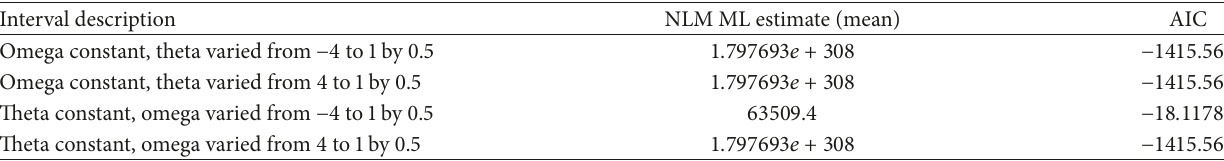
Table 10: Summary of results for lambda = 0.1, 𝑛 = 10 𝑖 , 𝑖 = 5 .